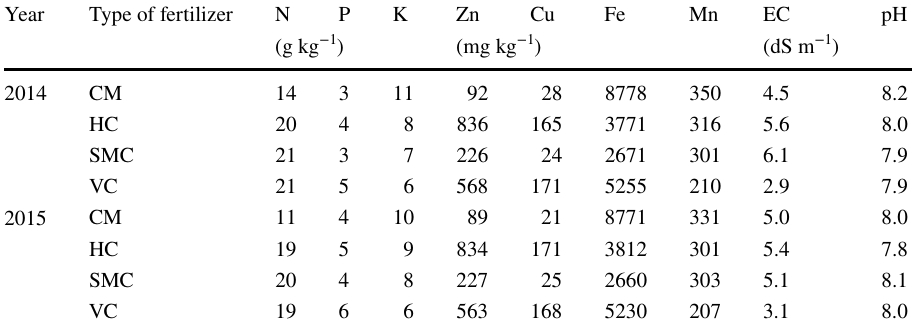
characteristics of applied organic